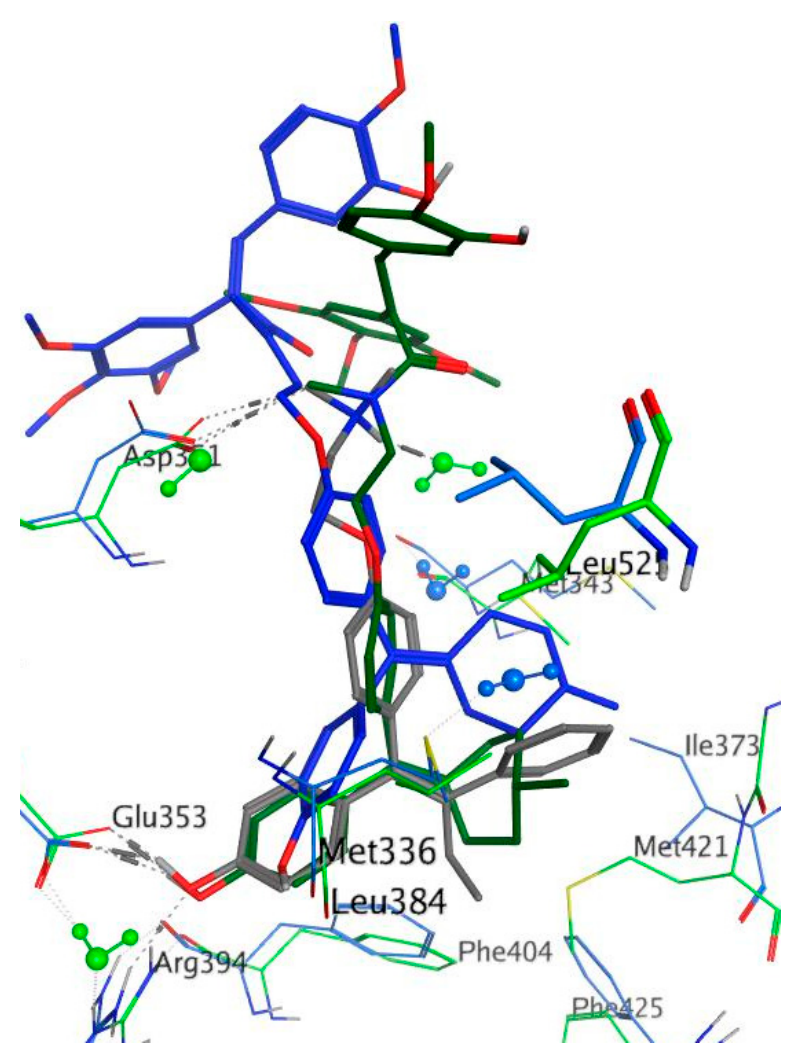
Figure 4. Ranked poses of 13e in ER α and ER β overlaid on 4-OHT X-ray structure. The potential clashing interaction between Leu525/476 (rendered in tube style) of ER β with the methylamide of 13e is present. Carbon atoms of 13e are illustrated in dark green in ER α , dark blue in ER β and grey in 4-OHT (oxygen atoms are red; nitrogen in dark blue; sulphur in yellow). ER α and associated water molecules are in light green, ER β and associated water molecules are in light blue. Amino acid numbering is for ER α except when different in ER β where both labels are used. PDB structures 3ERT [69] and 1NDE [70] were used for molecular docking.